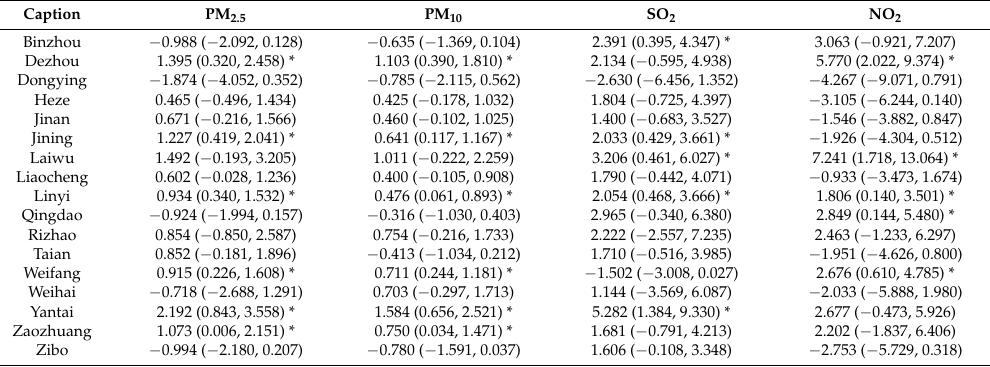
Table A11. Percentage changes of the relative risk of COPD hospitalizations for patients aged under 65 years and their 95% confidence interval (CI) per 10- µ g/m 3 increase in air pollutants in the 17 cities of the Shandong province, where * indicates statistically significant estimates ( p <